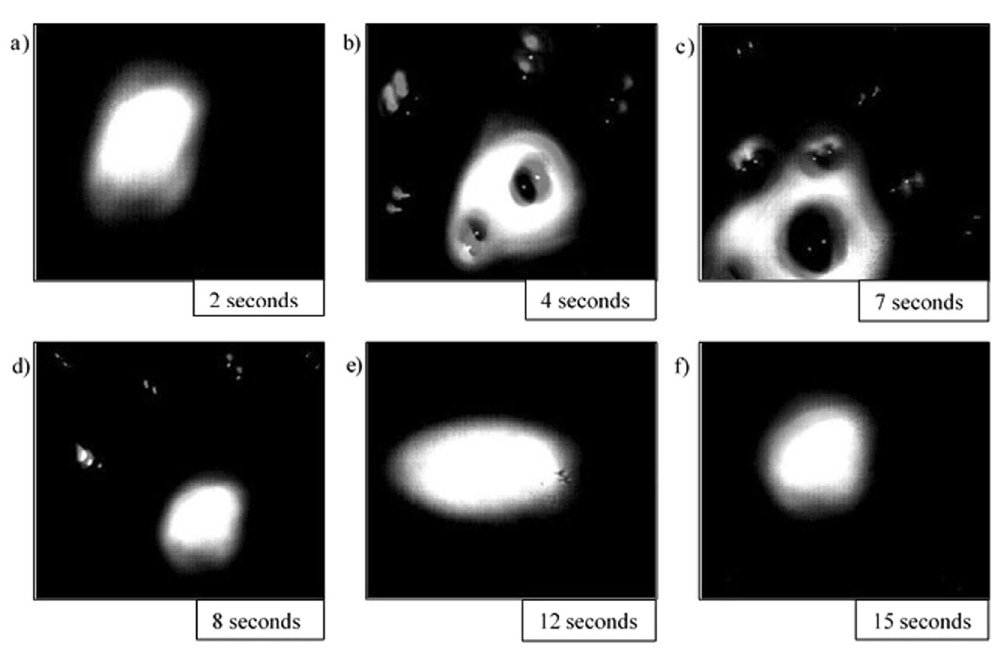
Figure 8. Time step images of the 1% FeAl experiment as seen in the HT-CSLM. In focus metal phases appear as lighter in grey scale and the molten metal oxide phase is seen as black. ( a–f ) Shows the cycle of perturbation growth to quiescent